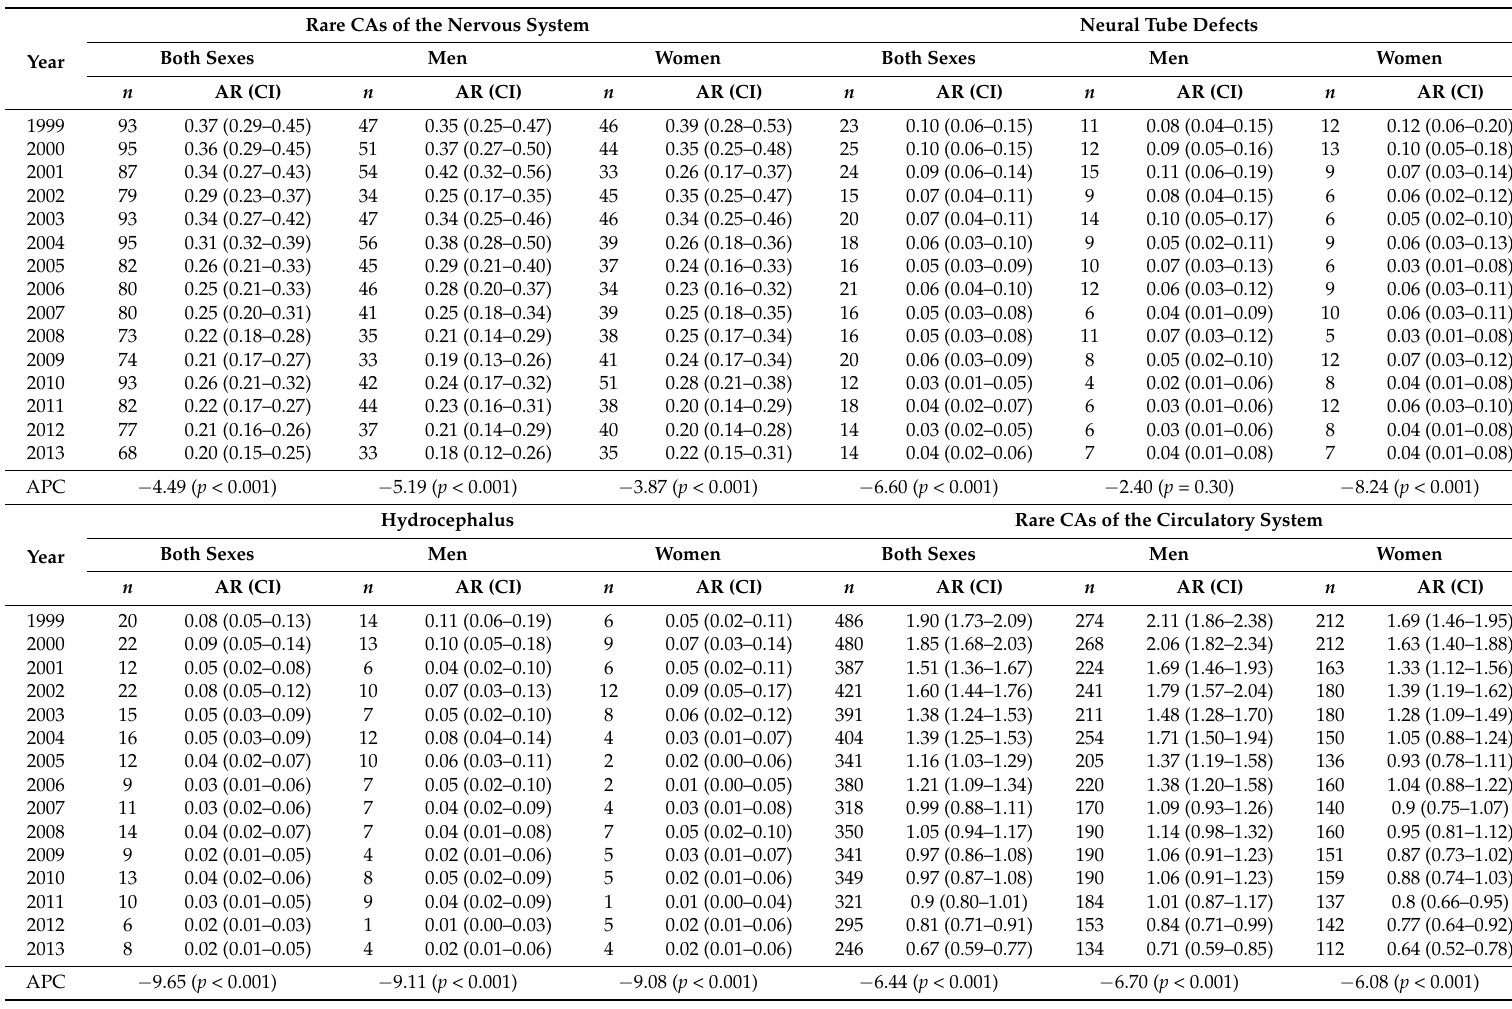
Table 2. Annual age-adjusted mortality rates (ARs) and 95% confidence intervals (CIs), by sex and type of rare congenital anomaly. Time trends results are shown as annual percentage change (APC) and p